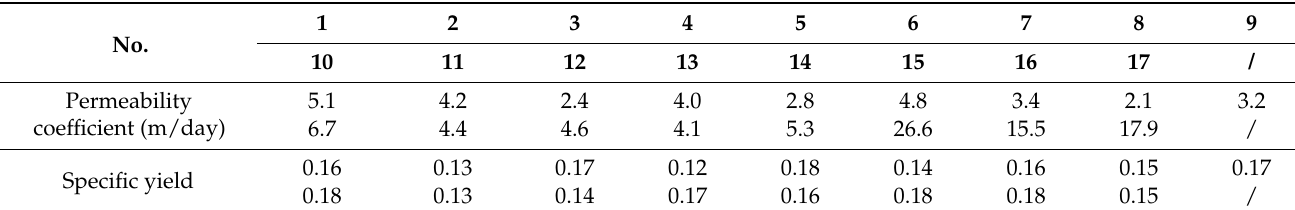
Table 1. Zoning results of hydrogeological parameters.